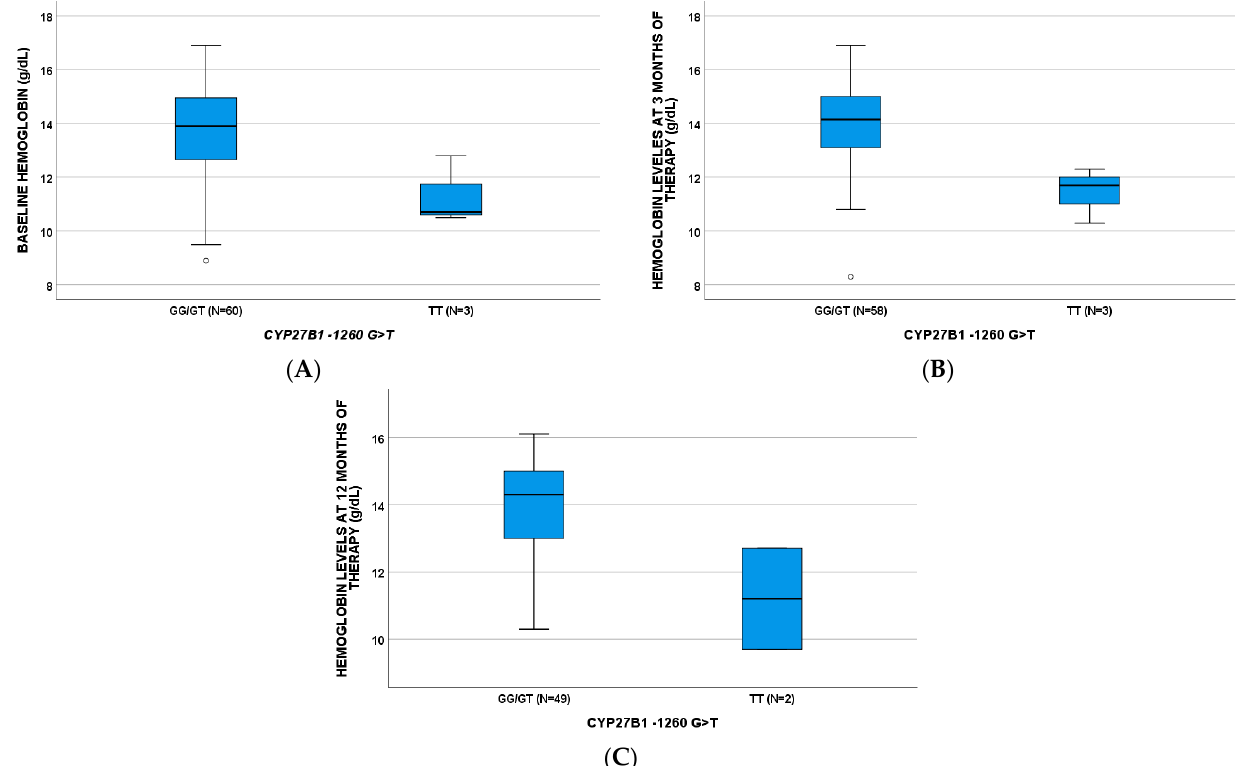
Figure 2. Hemoglobin levels according to CYP27B1 -1260G>T SNP at baseline ( A , BL, p = 0.023), three ( B , p = 0.011), and twelve ( C , p = 0.047) months of therapy. p -values are obtained through Mann–Whitney test. Table 3. Logistic regression analysis at three months of therapy. NSC: Not statistically comparable, as one group is missing; OR: Odds ratio , 95% IC: Interval of confidence at